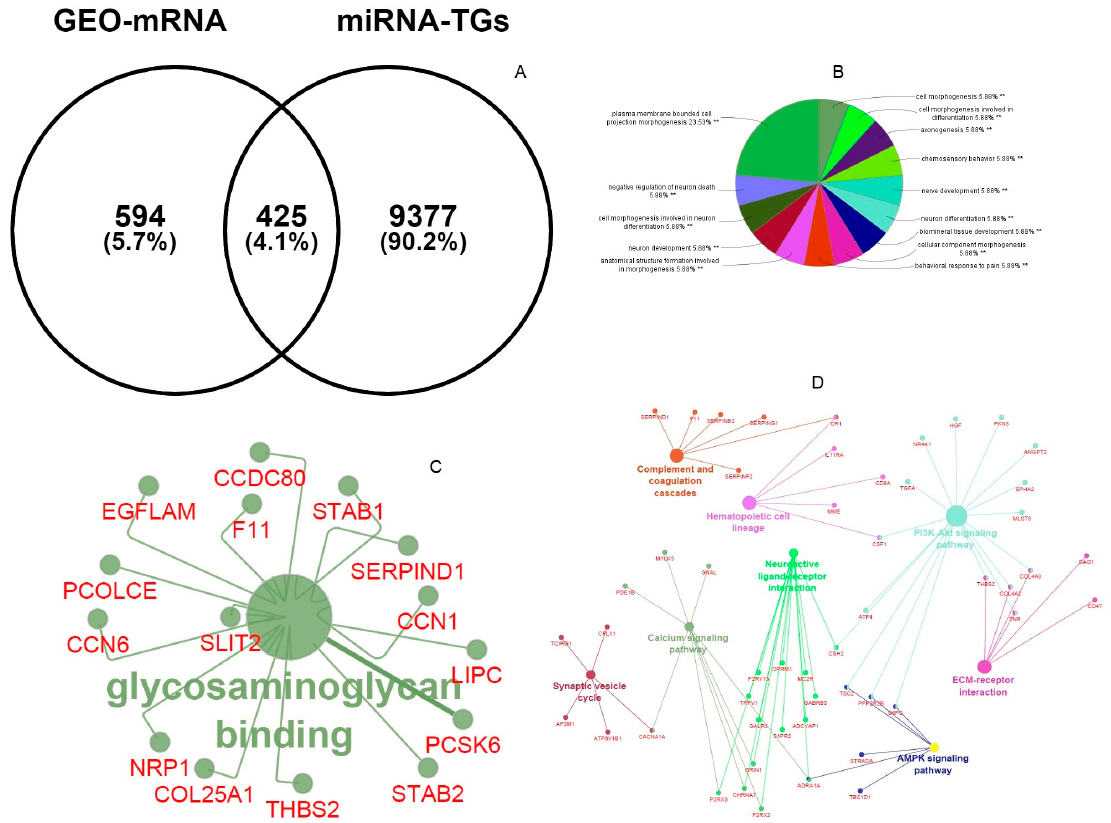
Figure 2. ( A ) Venny interactive diagram of overlapping miR-1246 genes and differential expression (DE)-cmRNAs. ( B ) Biological process of overlapping genes. ( C ) Molecular functions of overlapping genes. ( D ) KEGG pathway enrichment of overlapping genes.